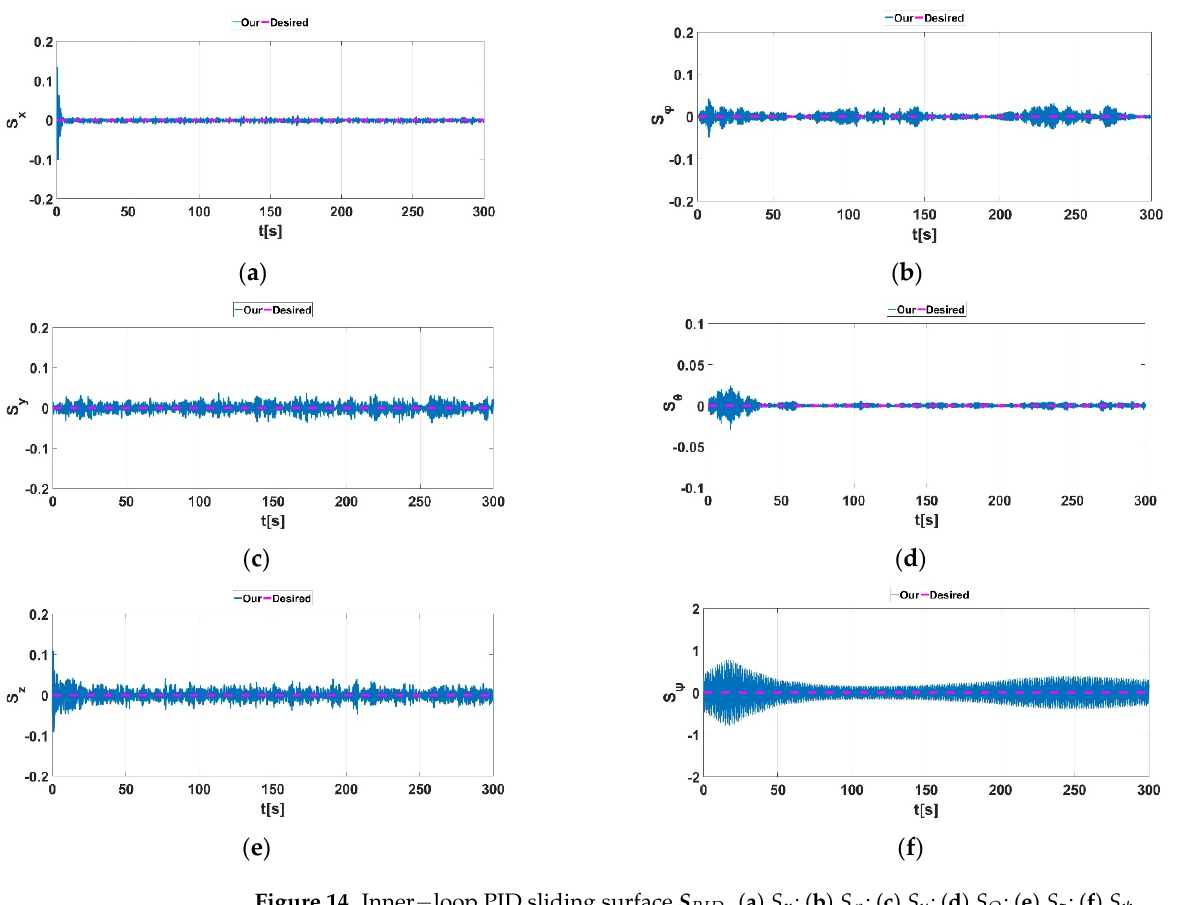
( f ) Figure 15. Outer − loop PID sliding surface 𝑺 𝒗 (cid:3556) . ( a ) 𝑆 𝑣𝑥 ; ( b ) 𝑆 𝑣𝜑 ; ( c ) 𝑆 𝑣𝑦 ; ( d ) 𝑆 𝑣𝜃 ; ( e ) 𝑆 𝑣𝑧 ; ( f ) 𝑆 𝑣𝜓 . To further verify the controller’s performance, the disturbance of the ocean current was further increased on the basis of (72). The attack angle and sideslip angle of the cur- rent were 𝛼 (cid:3030) = 𝑟𝑎𝑛𝑑(−1.57~1.57𝑟𝑎𝑑) and 𝛽 (cid:3030) = 𝑟𝑎𝑛𝑑(−3.14~3.14𝑟𝑎𝑑) , respectively. Equation (71) shows that such random changes in the angle of attack and sideslip angle